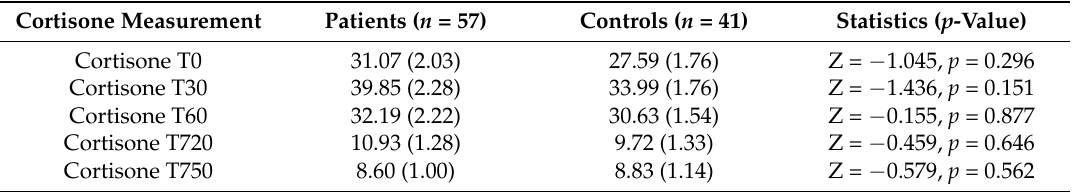
Table 4. Raw cortisone data for patients with MDD and healthy controls. Cortisone Measurement